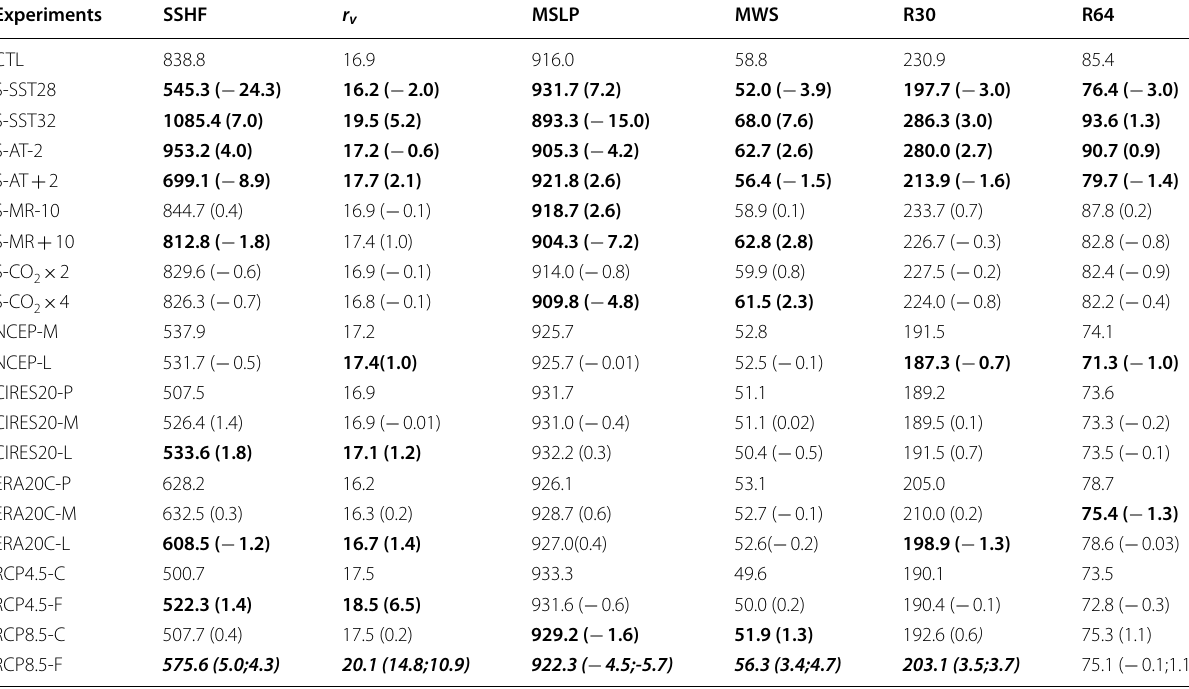
The sensitivity experiments are compared to CTL The NCEP/NCAR R-1 experiments are compared to each other. The CIRES20 and ERA20C experiments are compared to their pre-stage. The future scenarios used in RCP4.5 and RCP8.5 experiments are compared to their current-stage, RCP8.5-C is compared to RCP4.5-C, and RCP8.5-F comparison to RCP8.5-C is shown by italic values. SSHF ( r v) is the average SSHF ( r v) within 300 km of the vortex center in units of W m 2 (g kg − 1 ). MSLP (MWS) is minimum sea level pressure (maximum wind speed) in units of hPa (m s − 1 ). R30 and R64 are the azimuthally averaged radius from the vortex center of the 10-m 15 and 32 m s − 1 wind, respectively. A two-tailed moving-blocks bootstrap-based test with 10,000 resamples and a two-sample z -test are used for comparing two means and a null hypothesis of no difference. Bold and italic values indicate significance at the p < 0.01 level with an effective degree of freedom around 10. Parenthesized numbers indicate the Cohen’s d effect size of each variable by subtracting the mean of two samples and then dividing the value by the standard deviation. For RCP8.5-F, the first (second) parenthesized number represents the Cohen’s d effect size between RCP8.5-C and RCP8.5-F (RCP4.5-F and RCP8.5-F). There are 289 data samples at 10-min intervals in every